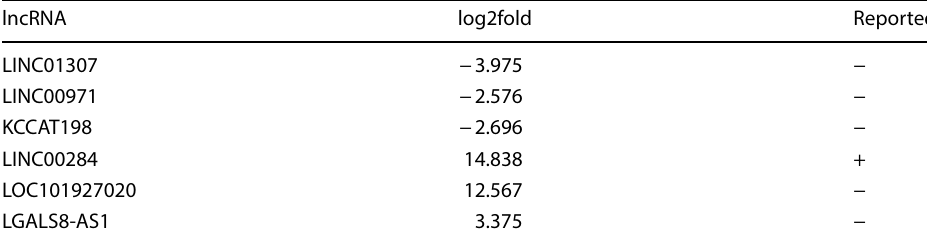
Table 14 Top three downregulated and upregulated lncRNA transcripts in OS-R compared to OS